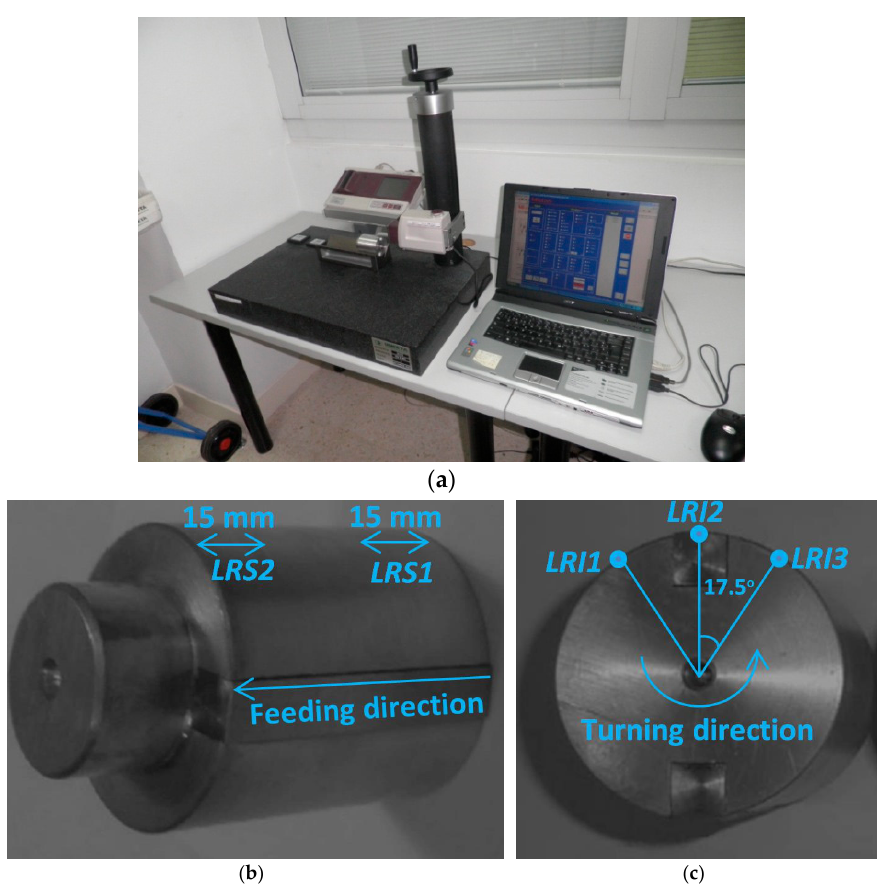
Figure 6. ( a ) Mitutoyo Surftest SJ 401 roughness tester; ( b ) the location of the measurements along the feeding direction; and ( c ) the location of the measurements according the turning direction.